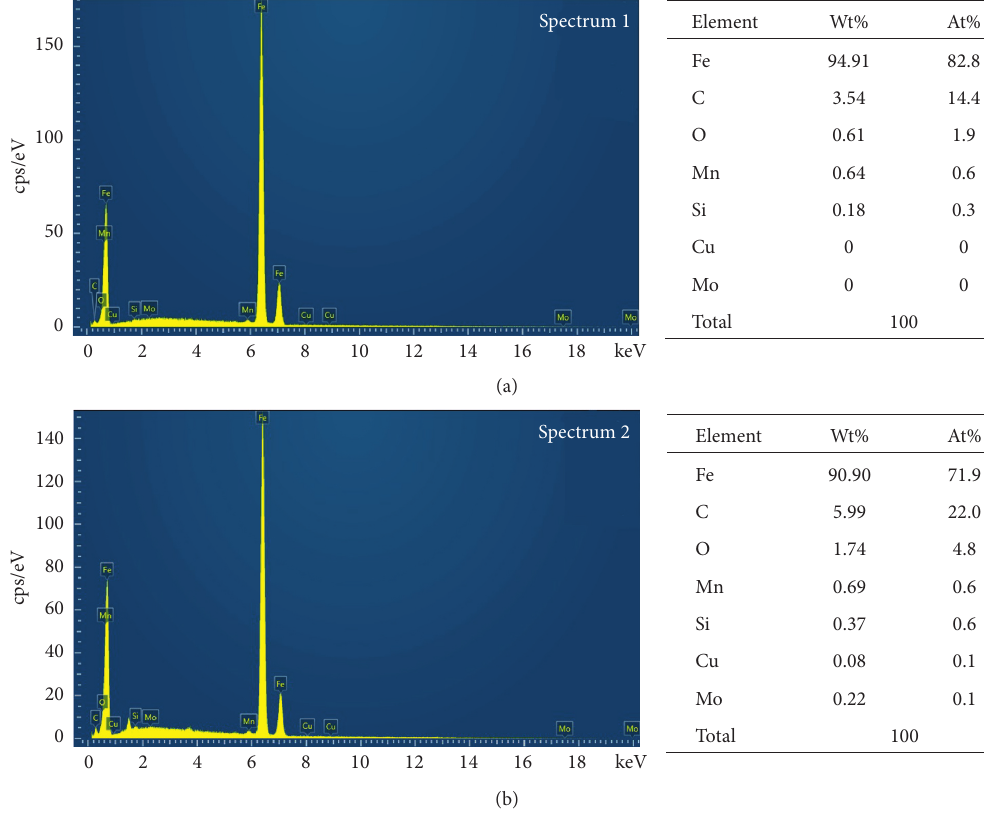
Figure 7: EDS element analysis. (a) Spherical object. (b) Long strip.